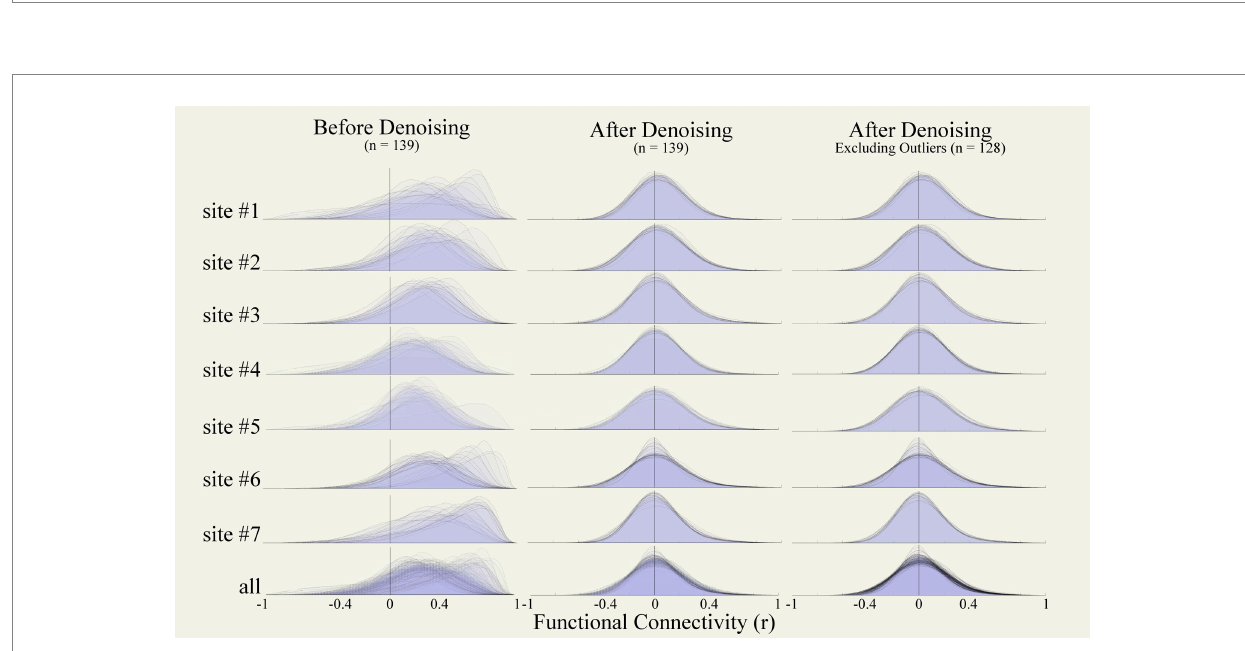
FIGURE 10 Functional connectivity density distributions. Density distributions of within-run FC strengths ( r coefficients) between all pairs among 1,000 randomly selected voxels from functional runs of the entire data collection ( n = 139) before (left) and after denoising (central), and after excluding outlier runs (right, n = 128). FC distributions are plotted for data from each site independently (top) and from all sites jointly (bottom row). FC, functional